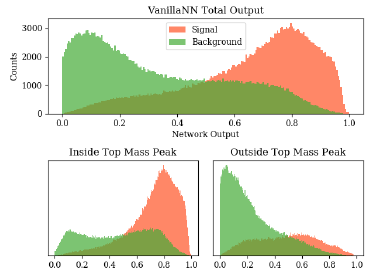
Figure 7. Output histograms for a sample Lorentz network. The green background curve is more sharply peaked at low output com- pared to the Vanilla network